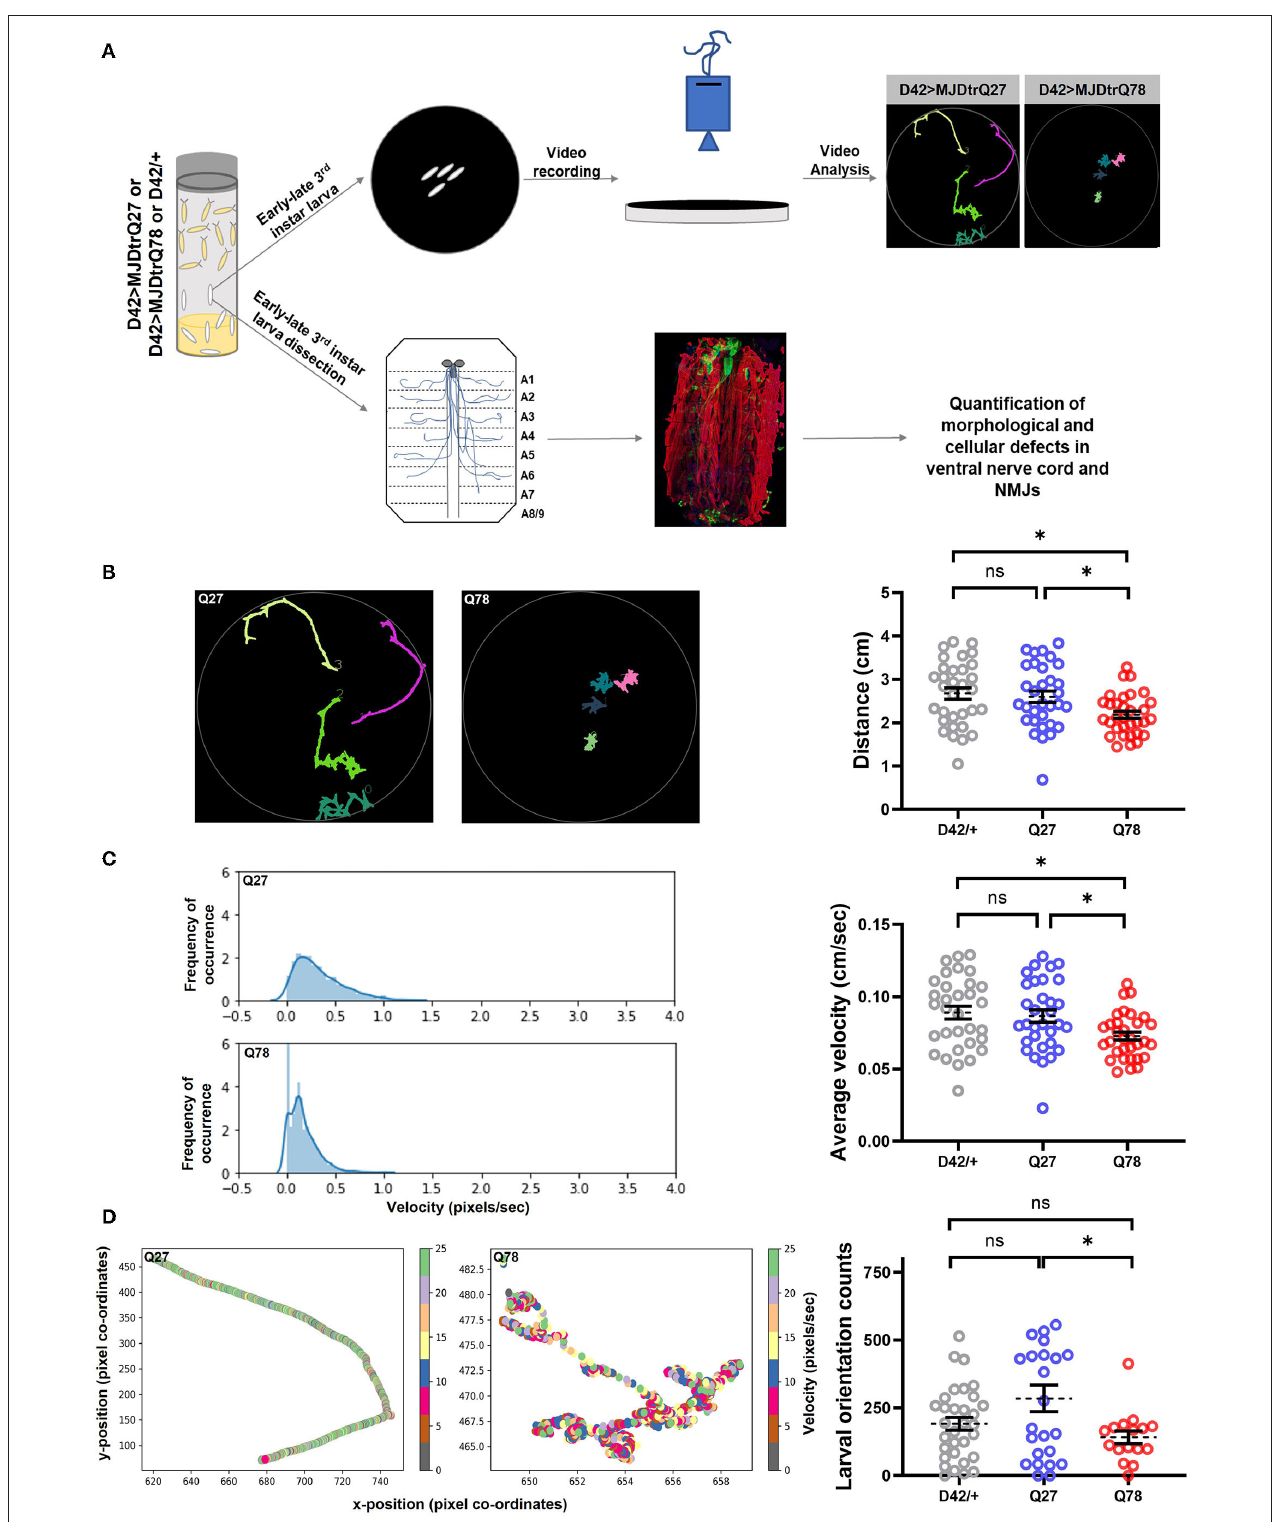
FIGURE 1 | Q78 expression in motor neurons leads to larval locomotion defect. (A) A flow chart of approaches to characterize behavioral and cellular defects upon expression of mutant MJDtrQ78. Third instar larvae expressing non-pathogenic Q27 or pathogenic Q78 along with driver control D42/ + were subjected to a larval locomotion assay and simultaneously assessed for phenotypic and functional defects in NMJs. (B) Path diagrams for Q27 and Q78 larvae monitored in 1% charcoal